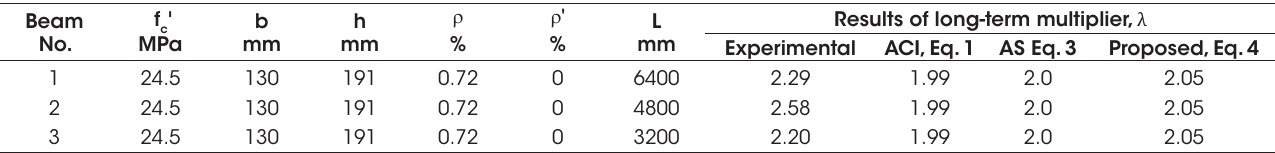
Validation of proposed long-term deflection multiplier ( λ ) with experimental results by [29], time of sustained loading = 4.75 years Beam No.